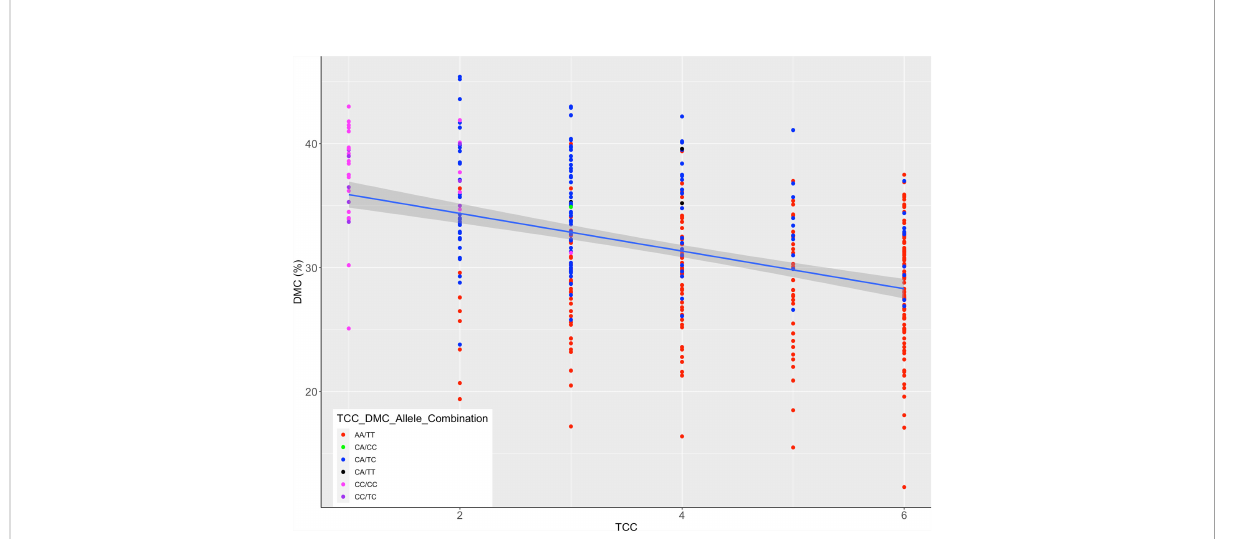
FIGURE 6 Scatter plot of total carotenoids content (TCC) and dry matter content (DMC) scaled by alleles for markers PSY2_572 and S1_24197219; the legend shows TCC/DMC allelic combinations of the two markers in genotypes assayed; the allelic states correspond to homozygous favorable alleles, heterozygotes and the wild type, as indicated in Figures 4,